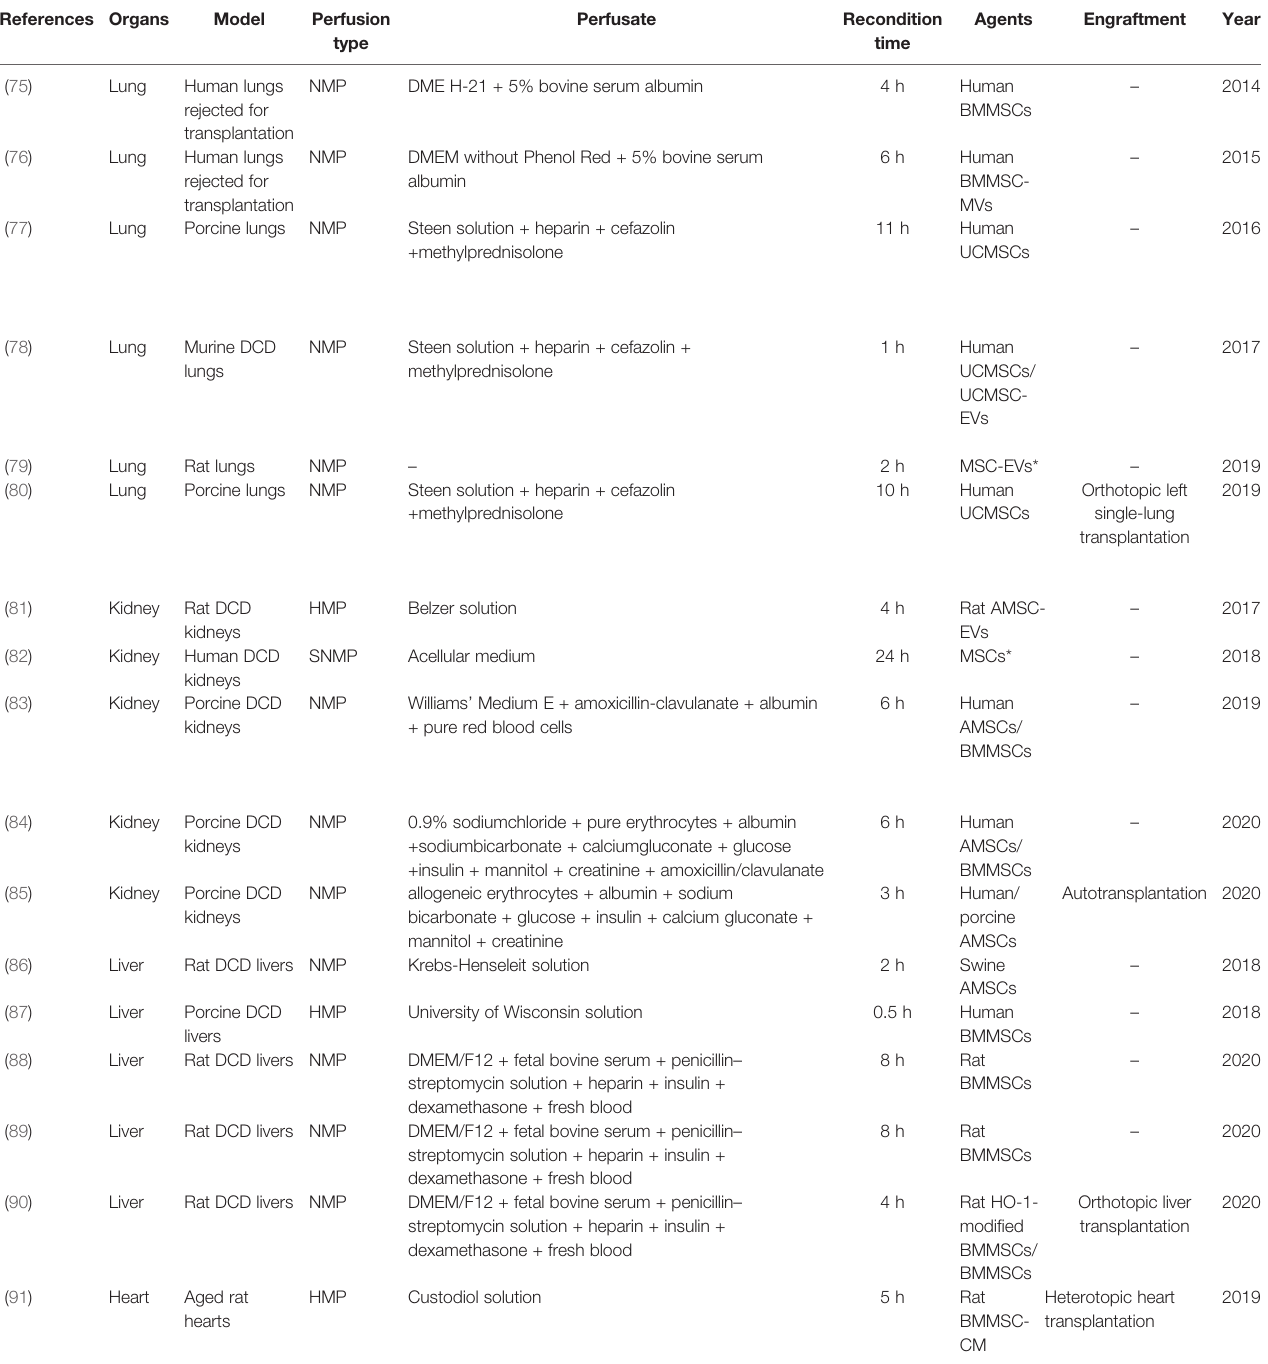
TABLE 1 | Recent studies regarding the applications of MSCs during machine perfusion on organ